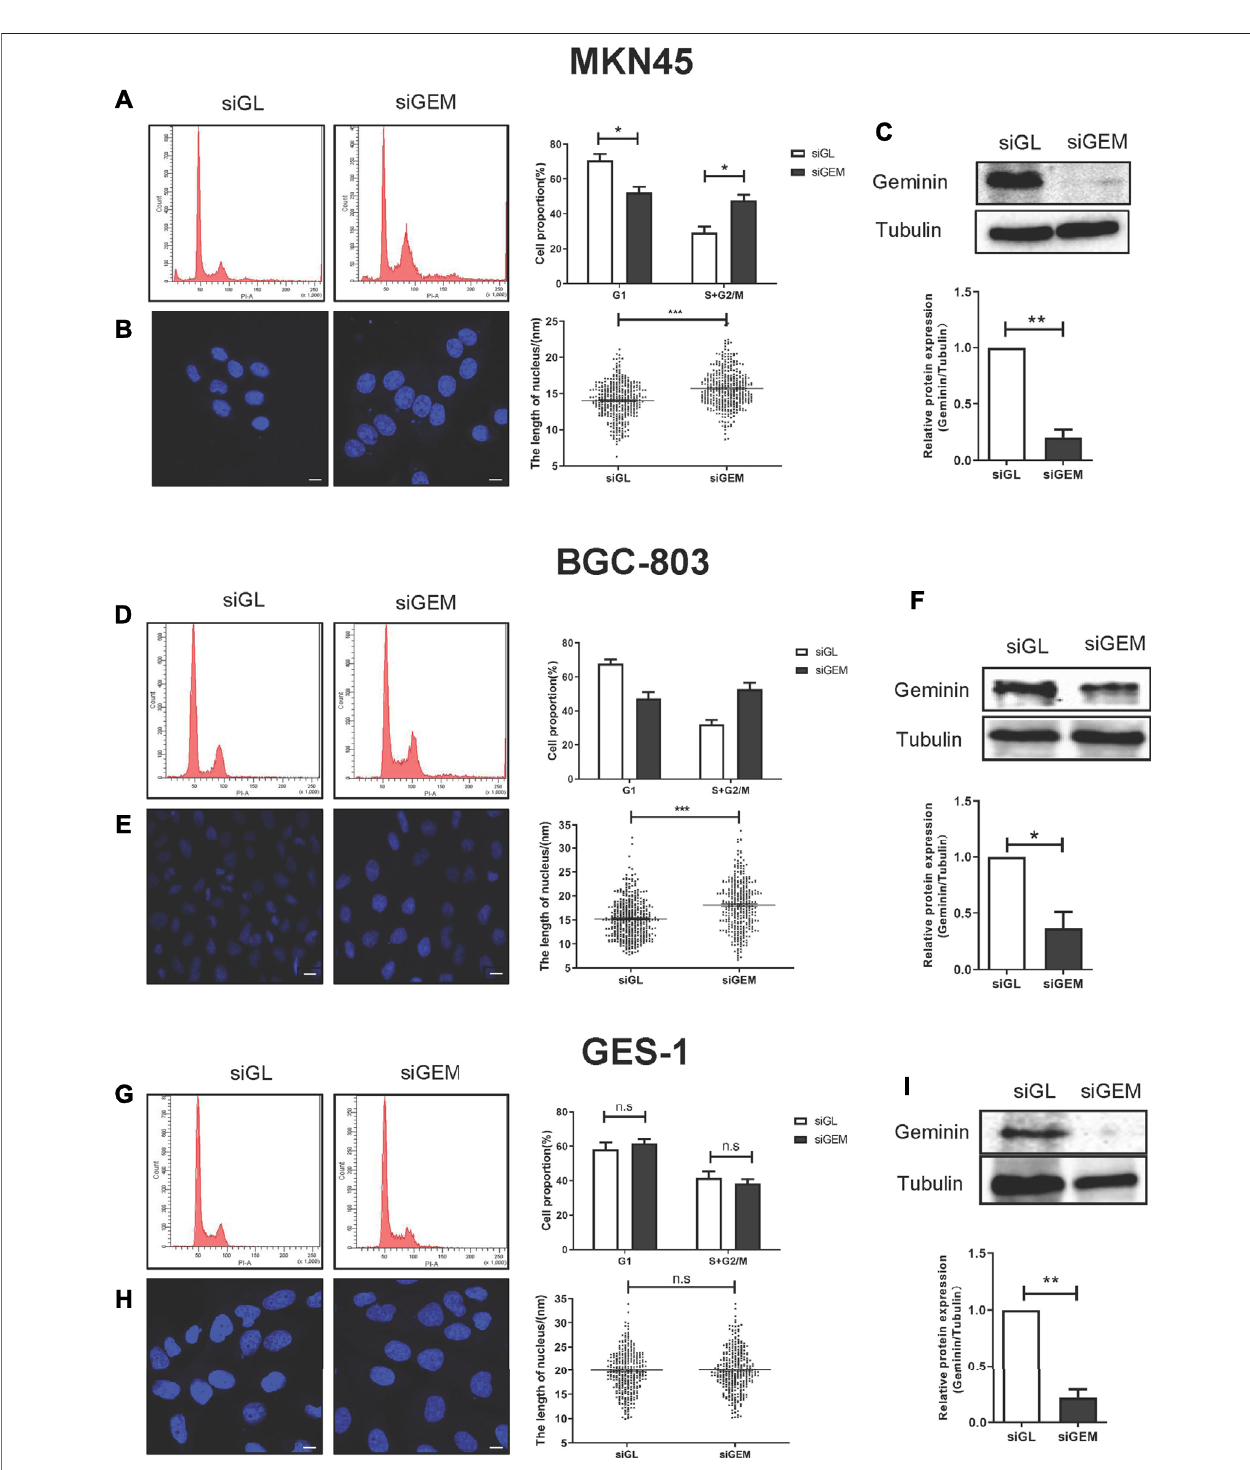
FIGURE 2 | Depletion of geminin induces DNA re-replication in gastric cancer cells but not in normal gastric epithelial cells. Two gastric cancer cells (MKN45 and BGC-803) and normal epithelial cells (GES-1) were transfected with siGL or siGEM. After 48-h posttransfection, the cells were harvested and stained with PI to quantify DNAcontentbyFACSanalysis (A,D,G) orwithDAPItovisualizenucleibyLSM (B,E,H) .GemininandtubulinweredetectedbyWesternblotting (C,F,I) .Densitometory of three independent experiments was performed, normalized to tubulin, and expressed as a ratio of siGL, respectively, mean ± SD, * p < 0.05, ** p < 0.01, *** p < 0.001 (T